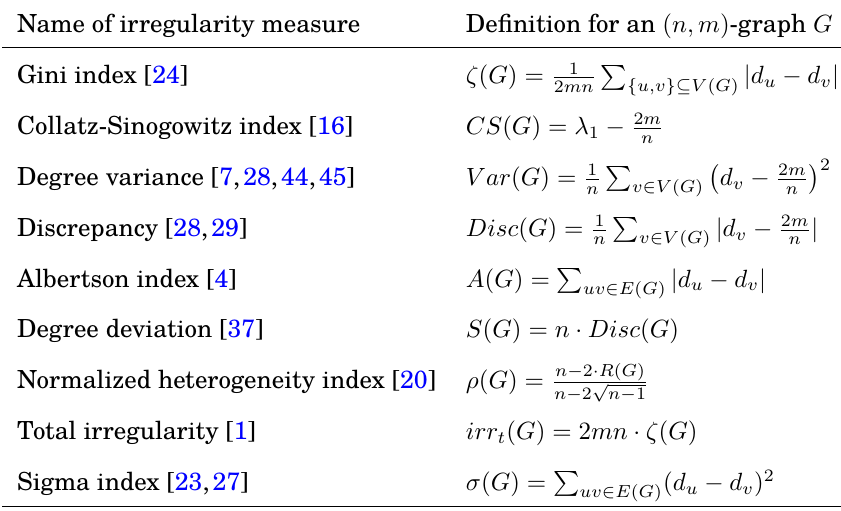
Table 1. Some existing irregularity measures considered in this